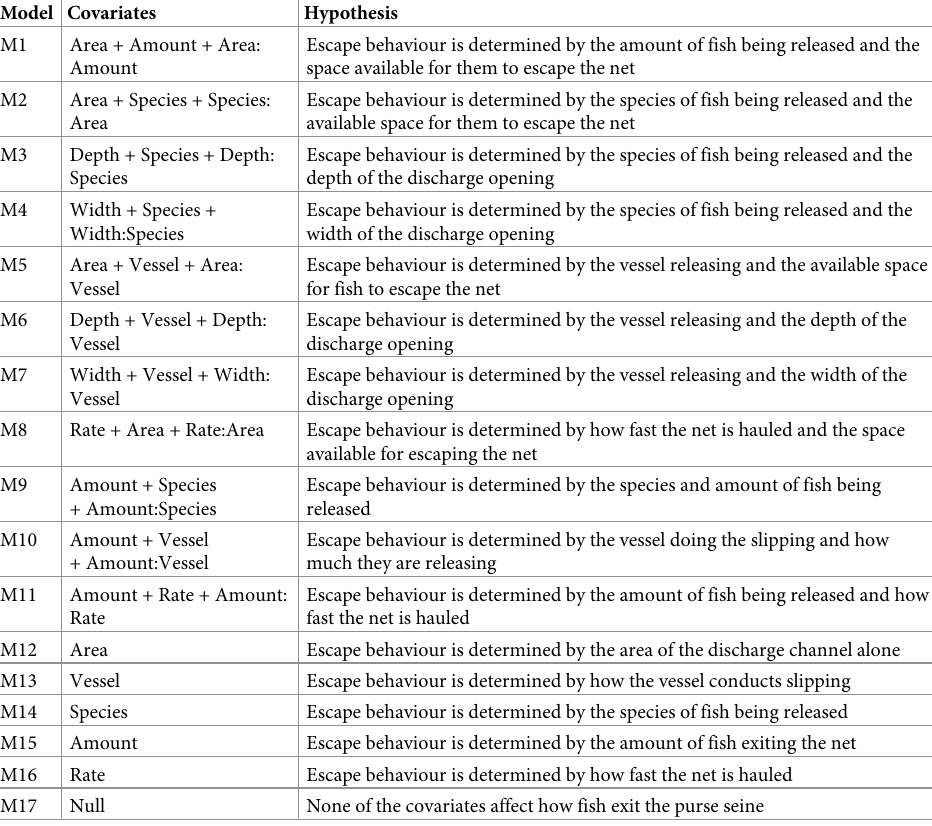
Table 2. Candidate Dirichlet regression models. Candidate models and associated hypotheses to explain the beha- vioural composition of fish whilst being slipped from purse seines. Model Covariates